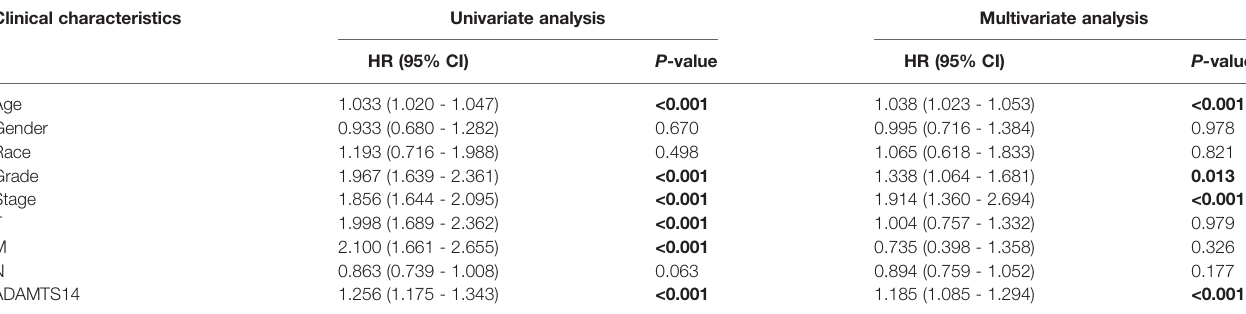
TABLE 1 | Associations between ADAMTS14, clinicopathologic characteristics, and OS in TCGA ccRCC patients by univariate and multivariate cox analysis. Clinical characteristics Univariate